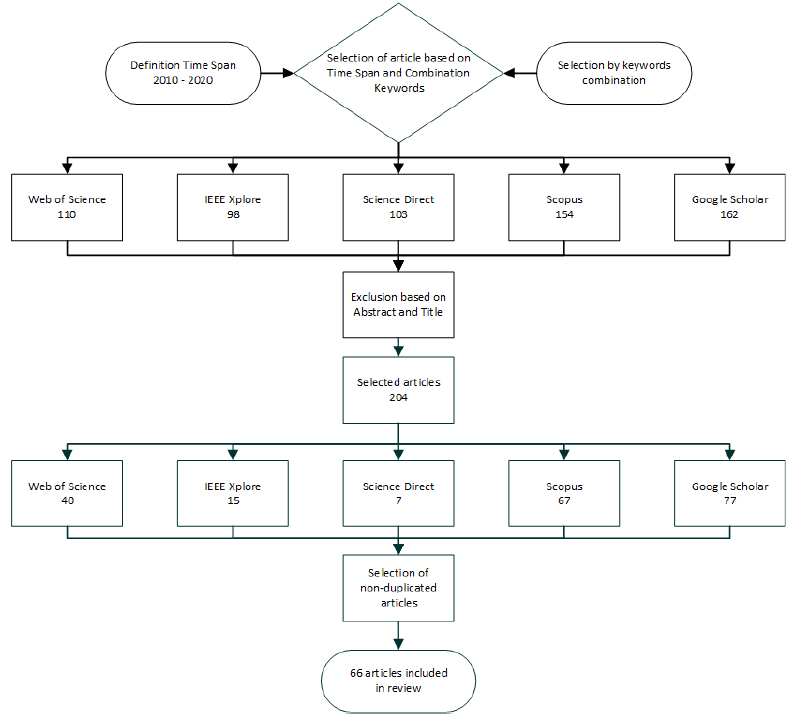
Figure 1. The process of selecting articles for the design and technical solutions of a tangible user interface (TUI) .